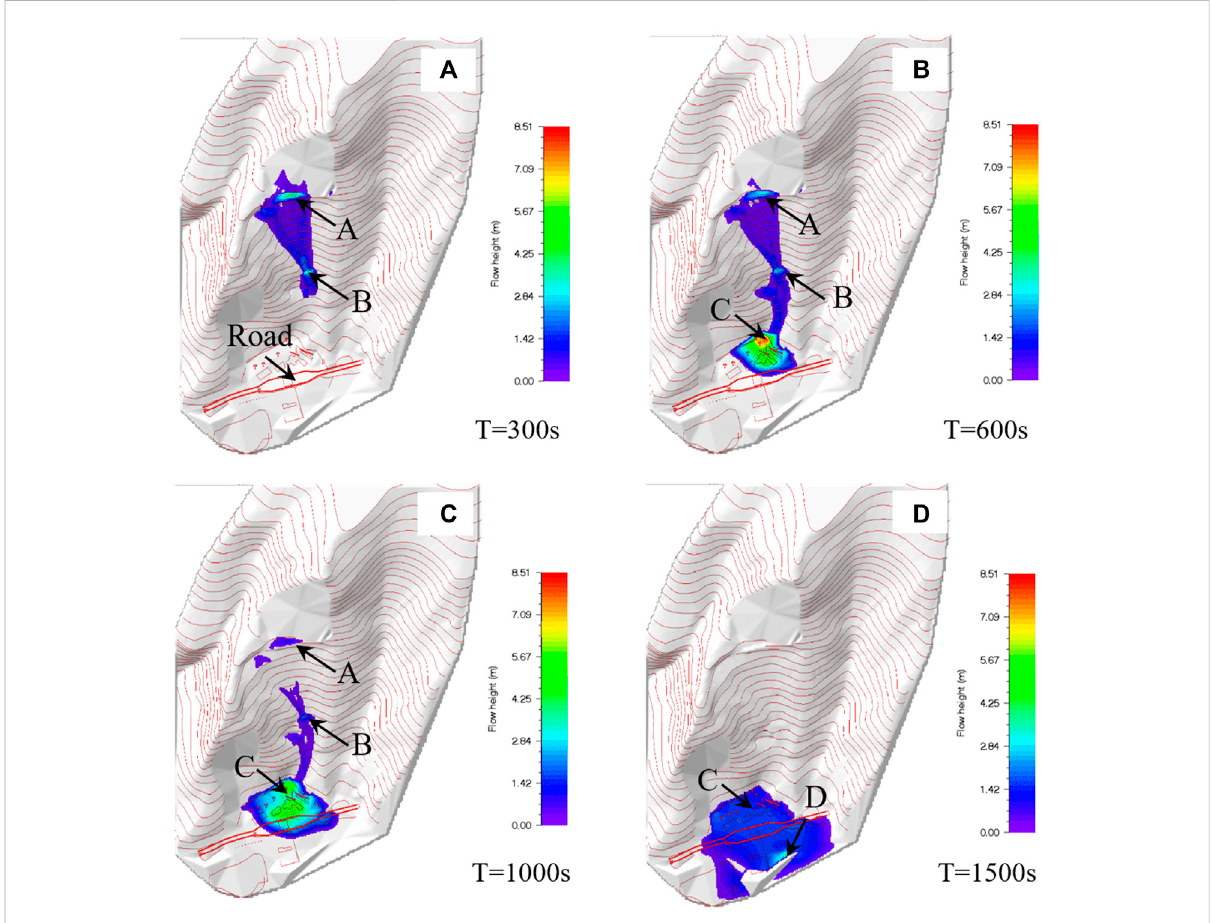
FIGURE 7 Variation of the deposition height of the debris fl ow on the slope surface under the condition of extreme rainfall once every 20 years at (A) t =150 s, (B) t =600 s, (C) t =1,000 s, and (D) t =3,000